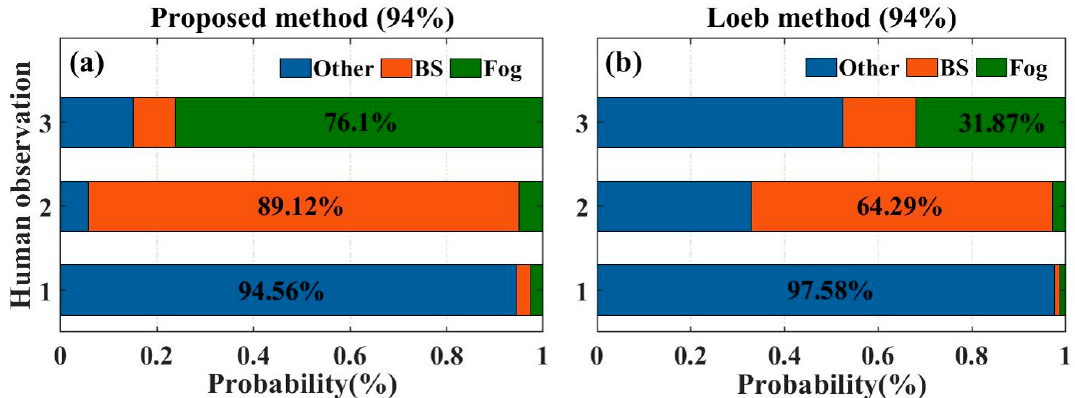
Figure 4. The accuracy of ( a ) the proposed algorithm and ( b ) the Loeb method under other situations (Other), blowing snow (BS), fog of human observation.